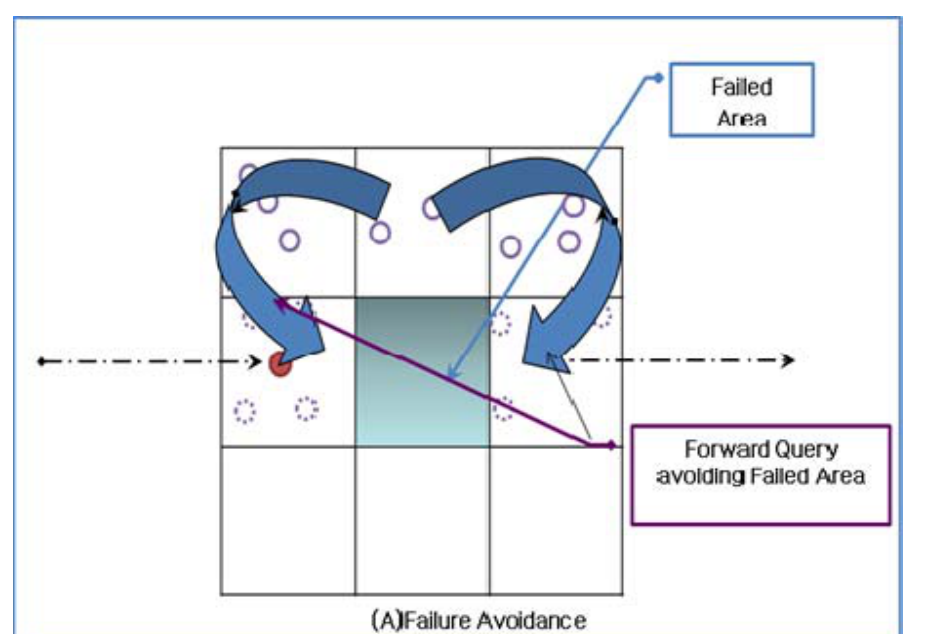
Figure 8. Failure Avoidance and